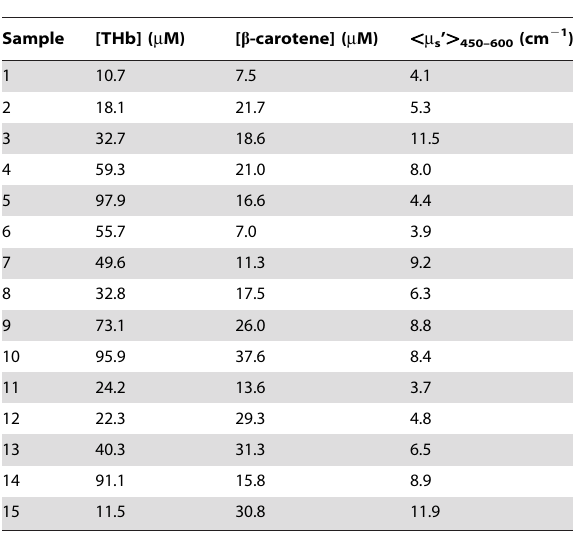
Table 1. Extracted ex vivo breast tissue properties used for training